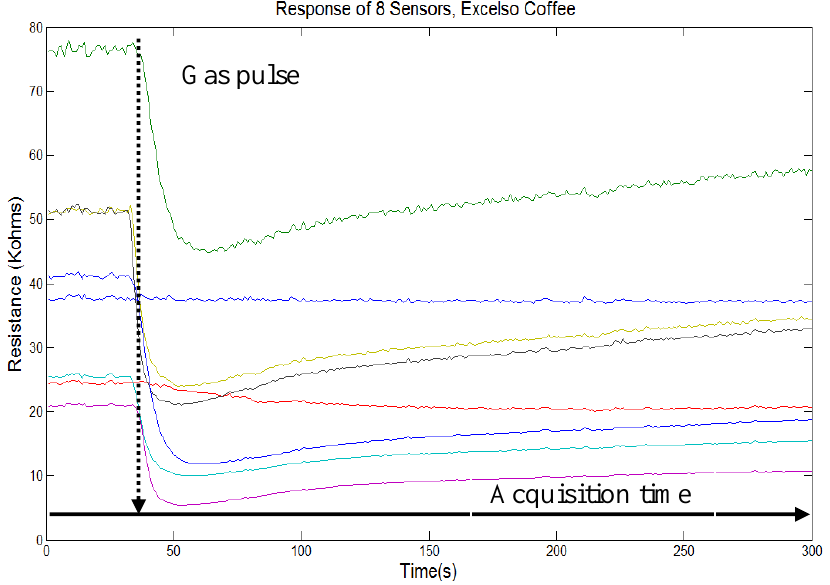
Figure 5. Sensor array response for Excelso coffee.